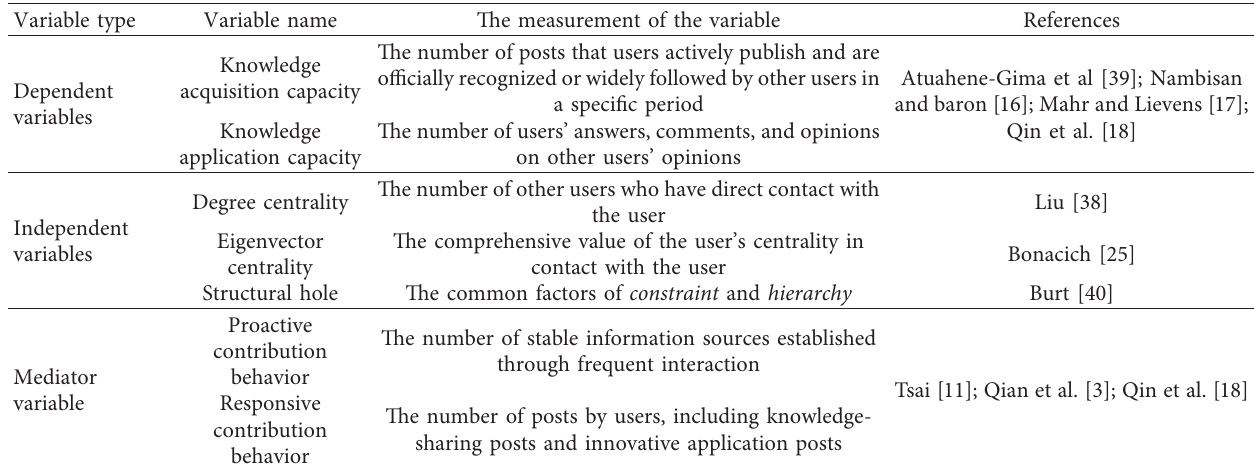
Table 2: The measurement of each research variable.